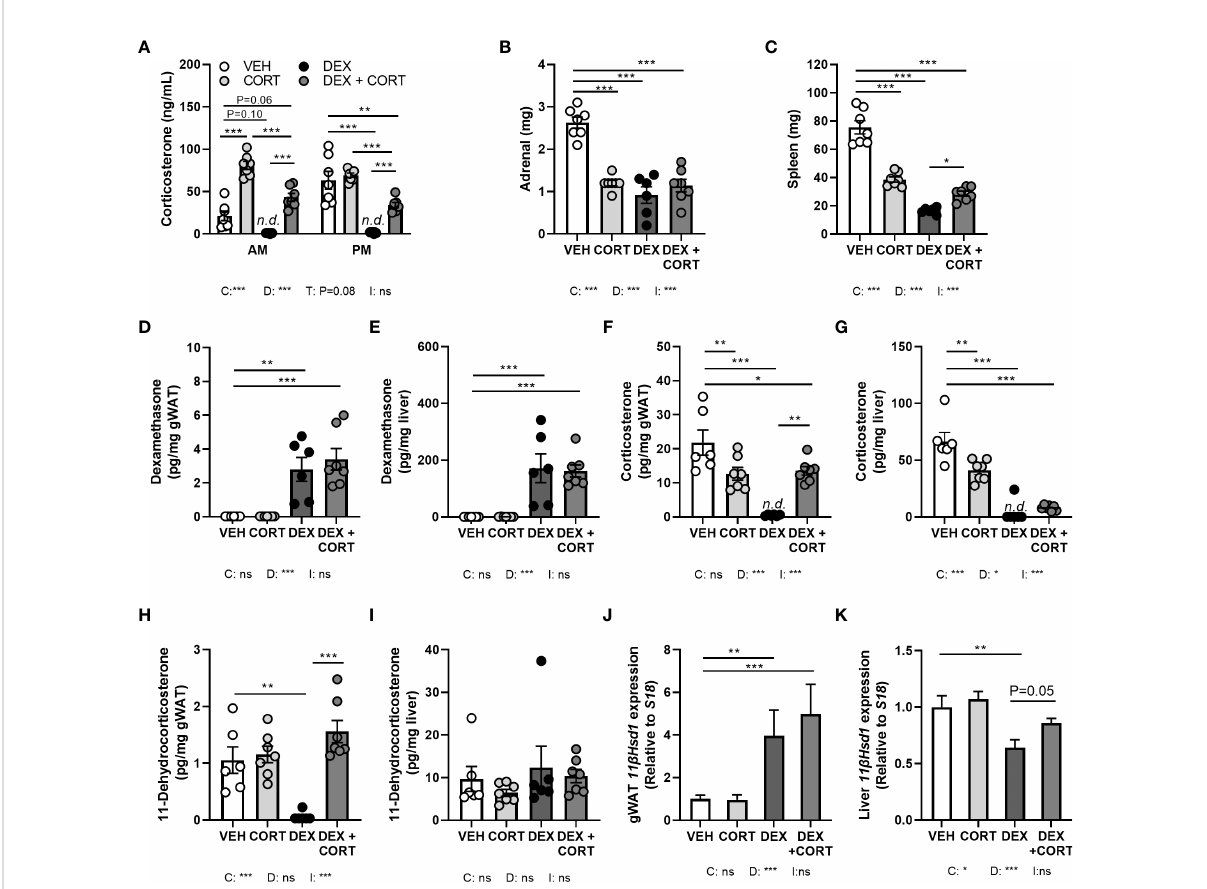
FIGURE 1 Dexamethasone depletes corticosterone levels in blood and glucocorticoid target tissues, while corticosterone add-on partially restores this. Mice received a high-fat diet mixed with dexamethasone (DEX) or vehicle (VEH) and were subcutaneously implanted with low-dose (5 mg) corticosterone (CORT) or vehicle pellets for 3.5 weeks. (A) After DEX, plasma CORT levels were not detected (n.d.) at AM (ZT1) and PM (ZT11) of the light phase at day 8. (B, C) DEX strongly reduced adrenal and spleen weight. (D, E) Using LC-MS analysis, DEX levels were 100-fold higher in liver than in gonadal white adipose tissue (gWAT). (F, G) In gWAT and liver, DEX strongly suppressed CORT levels, which were (partially) restored by DEX + CORT. (H, I) DEX suppressed 11-dehydrocorticosterone levels in gWAT but not in liver. (J, K) 11 b Hsd1 expression was upregulated by DEX and DEX + CORT in gWAT and downregulated by DEX in liver. Statistical signi fi cance was calculated using 2-way ANOVA analysis in (B-K) , and 3-way ANOVA analysis in (A) Depicted below the graphs are the P-values of the ANOVA tests for either time (T), CORT (C), DEX (D) or the interaction between CORT and DEX (I). *P < 0.05, ** P < 0.01, ***P < 0.001. 'ns' means 'not signi fi cant'. n.d. means 'not